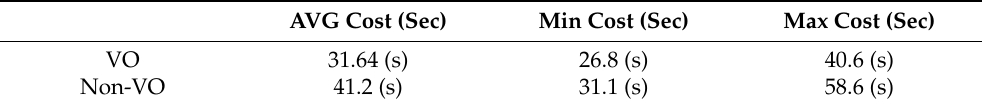
Table 2. Comparison of navigation time.